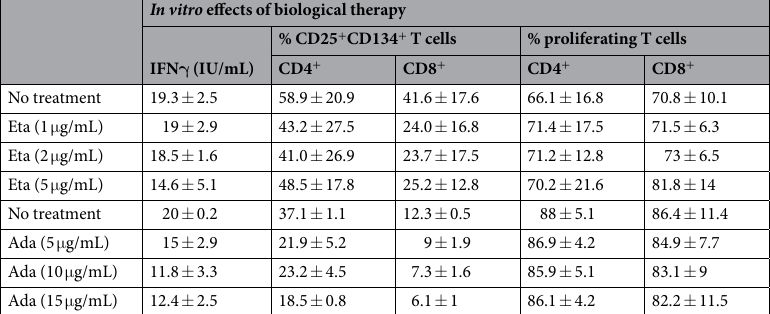
Table 3. Results from in vitro experiments: evaluation of IFN γ response, co-expression of CD25/CD134, and proliferation of T cells. The results are expressed as mean ± standard deviation. Note: Eta = etanercept; Ada =